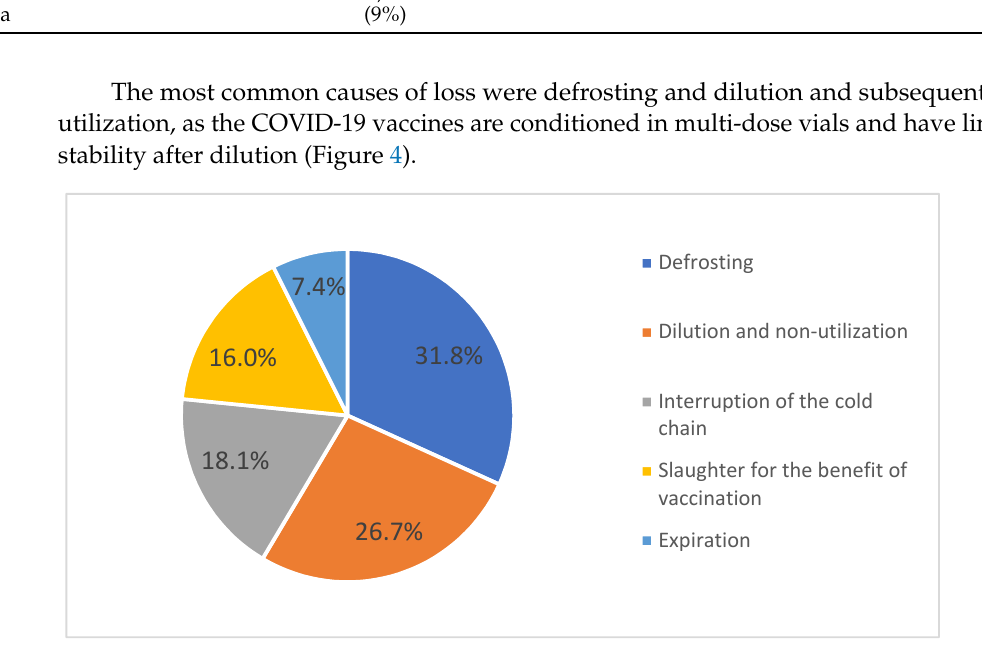
Figure 4. Reported causes of COVID-19 vaccine losses, Romania, 27 December 2020–31 December